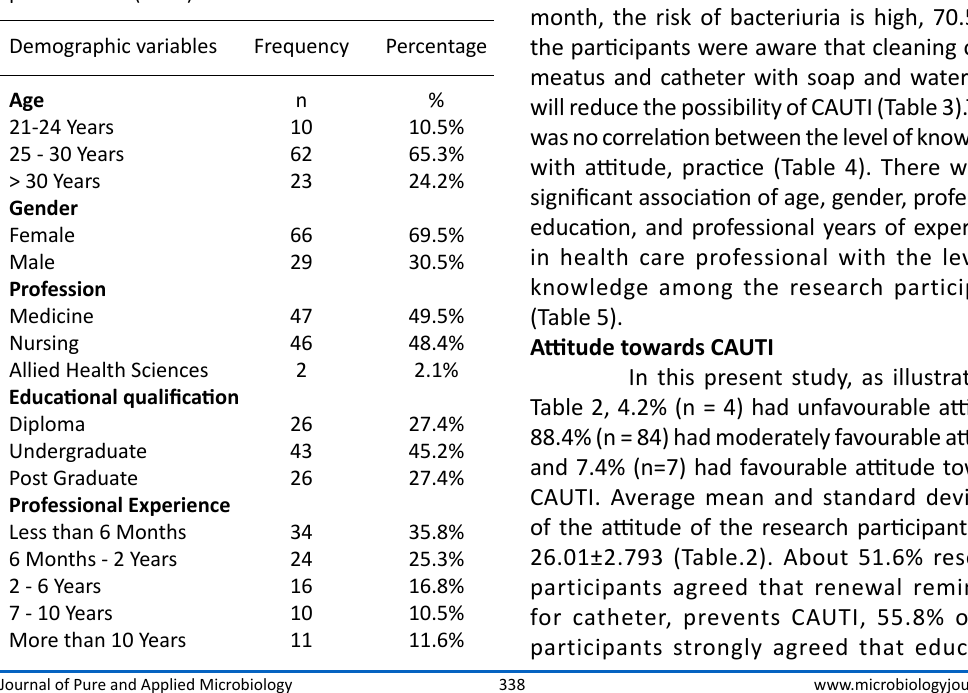
Table 1. Demographic characteristics of health